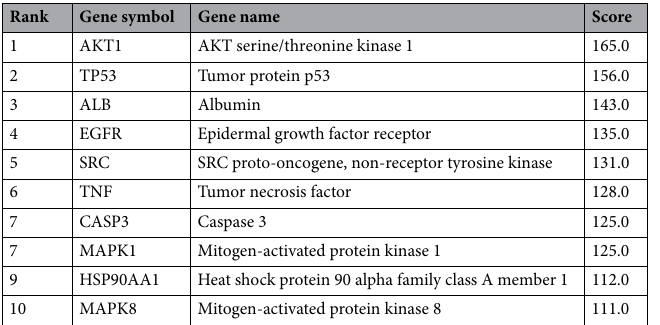
Table 1 . Top 10 proteins in the protein–protein interaction network, ranked by degree, as analyzed by